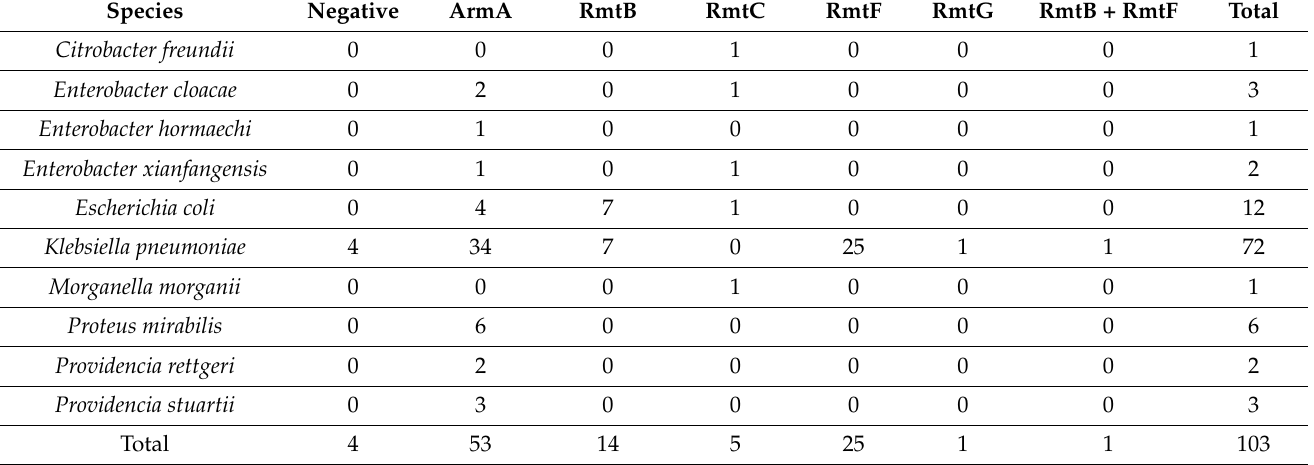
Table 1. Total number of 16S RMTases detected in pan-aminoglycoside and carbapenem-resistant enterobacterial species between 2017 and 2020 from the NARA.